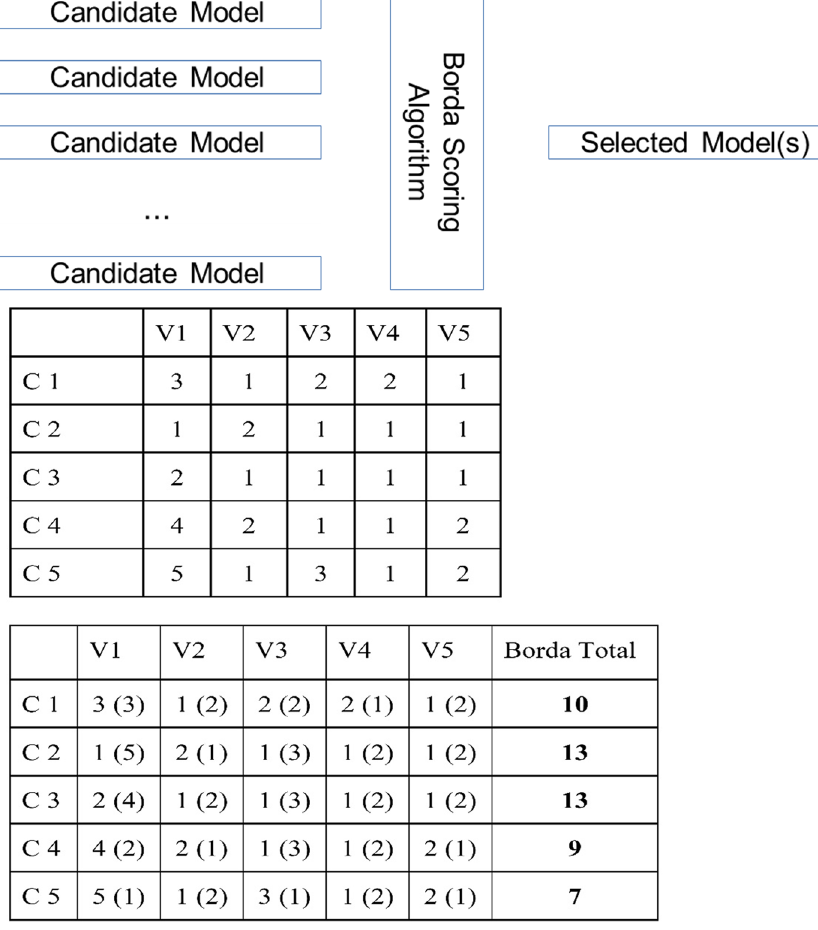
Fig. 1 Hypothetical com- petition rankings for two modeling competitions. This figure shows the architecture of the multi-criteria selec- tion procedure followed by hypothetical rankings of 5 models (or candidates) across 5 criteria (C1–C5) with Borda values (in parentheses) and total Borda scores shown in the lower